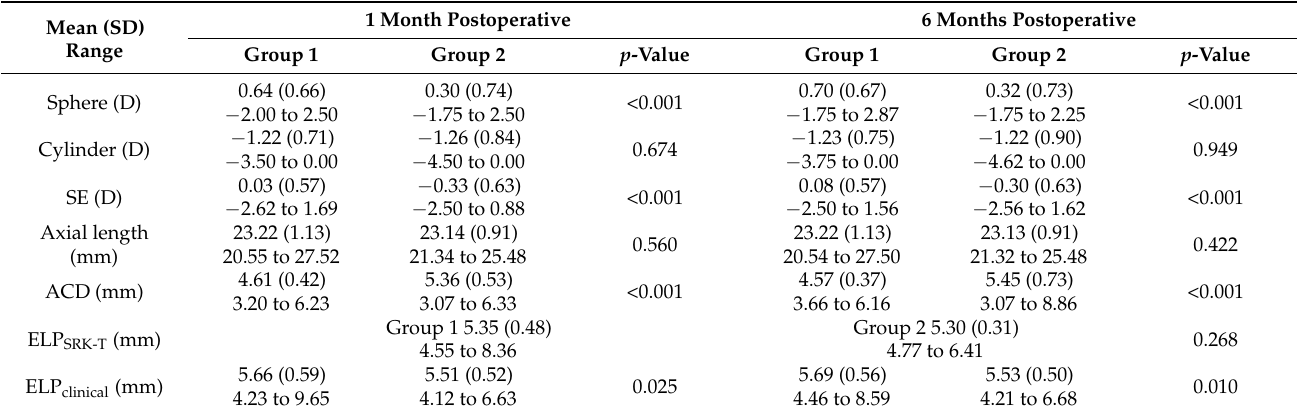
Table 2. Main postoperative outcomes in the two IOL groups of the current study: Group 1 (including 247 eyes implanted with the AcrySof SN60WF IQ IOL) and Group 2 (including 104 eyes implanted with the MI60L Akreos